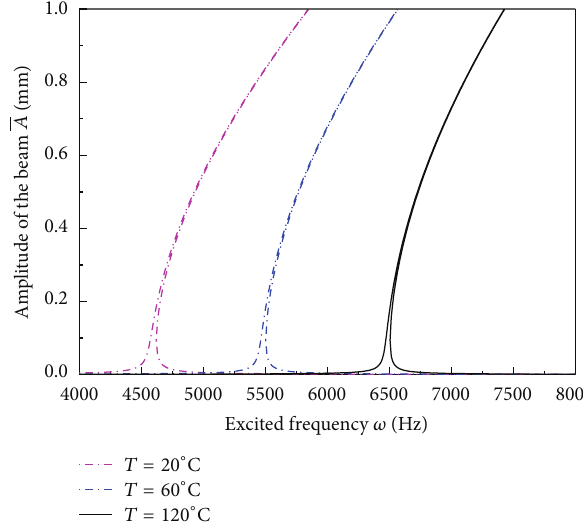
Figure 16: Amplitude 𝐴 versus frequency responses of the com- posite beams in the phase transformation state from martensite to austenite under the excitations for different 𝜀 0 ( T = 60 ∘ C, 𝑉 𝑠 = 0.005 , = 10 N, and 𝐿/ℎ = 10 ). 𝑞 0